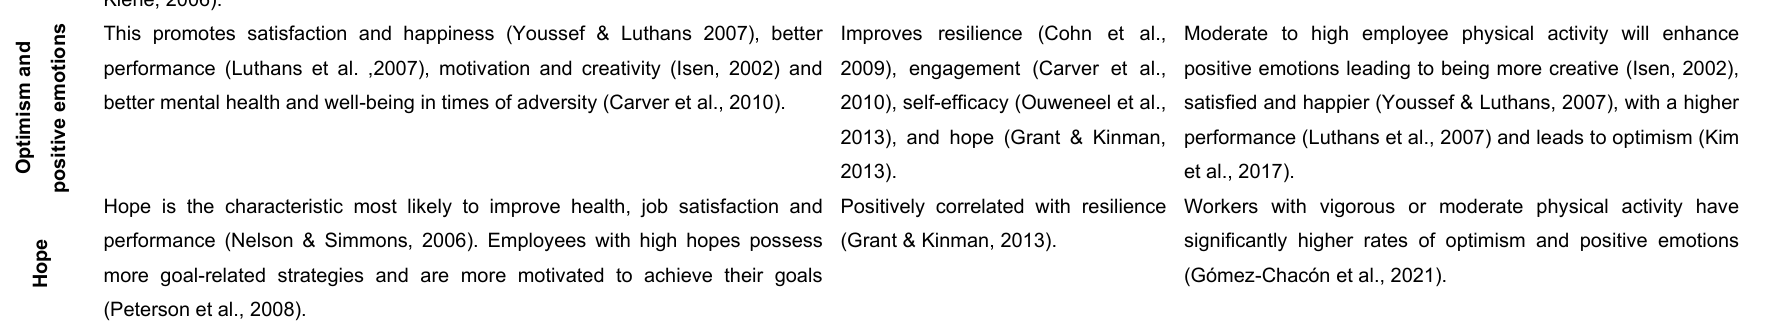
Main consequences of each strength Is interrelated to Influence of physical activity n t e m e g a ng E